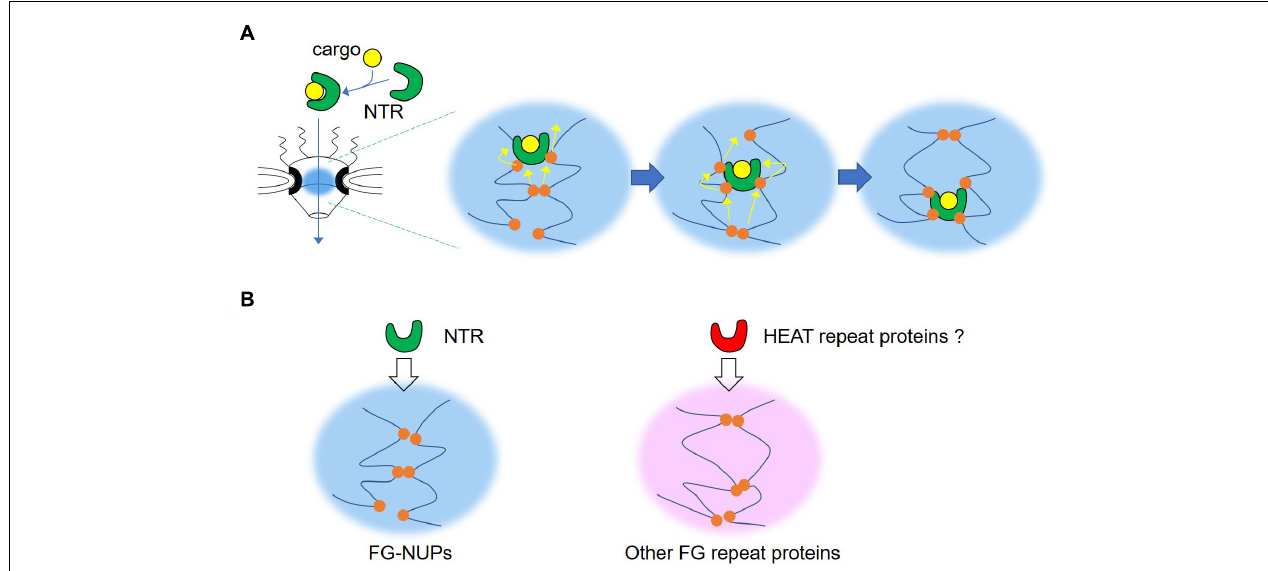
FIGURE 3 | Illustration of the mode of permeation of the nuclear pore of nuclear transport receptor. (A) Phenylalanine-glycine (FG) repeats interact with multiple binding sites on the nuclear transport receptor (NTR) surface, both multivalently and transiently. FG motifs can be displaced by other competing FG motifs, and slide on the surface of NTRs. By repeating this process, the NTR gradually moves to the nucleoplasmic side. (B) The NTR is responsible for specific transport through nucleoporins containing FG repeat domains (FG-NUPs). A similar mechanism might be shared among other FG repeat proteins and HEAT repeat